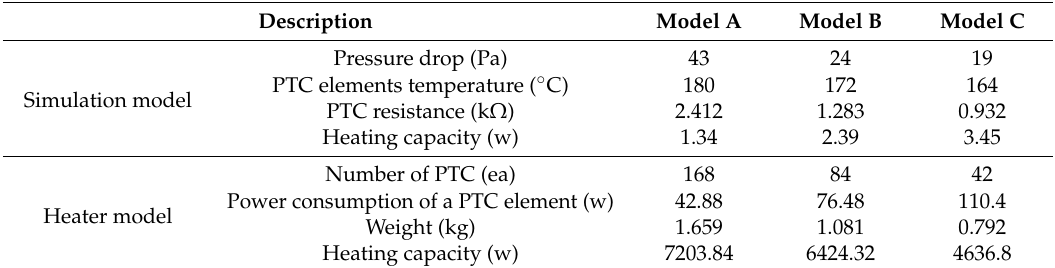
Table 4. Analysis results of simulation. Positive Temperature Coefficient.